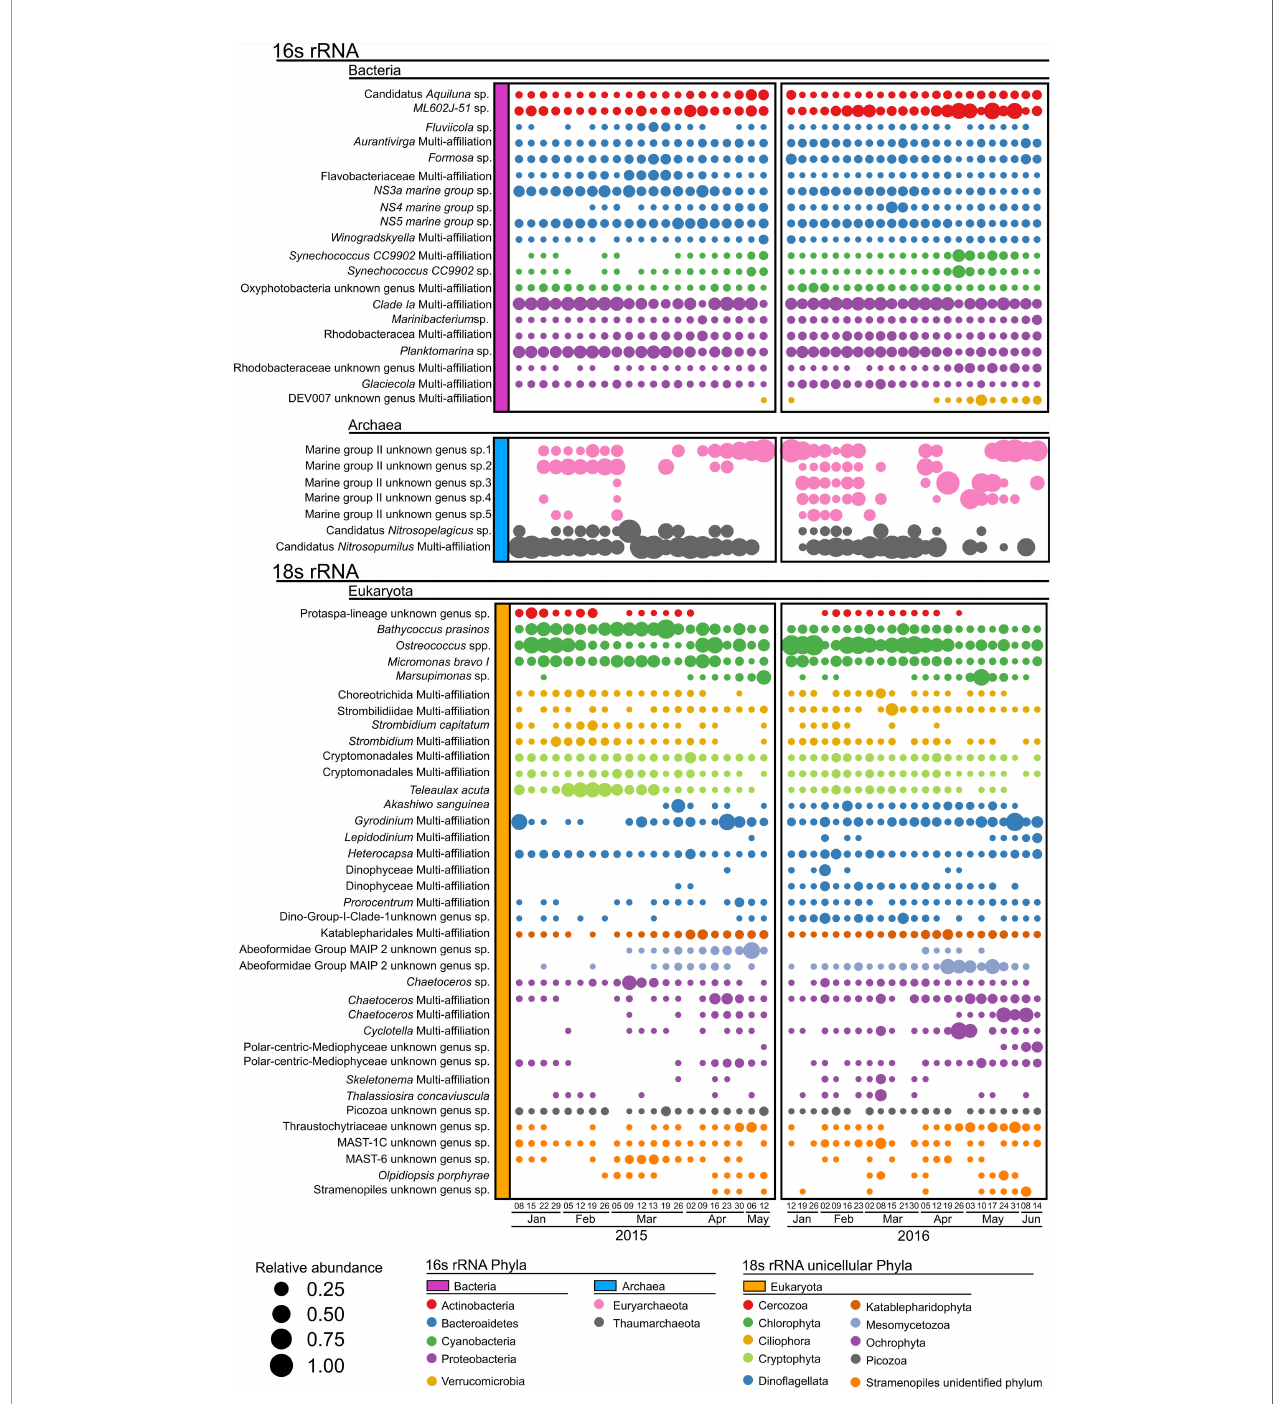
FIGURE 4 | Relative abundances ’ dot plot of the dominant OTUs for 2015 (left) and 2016 (right). Dots are proportional to the relative abundance of OTUs. Dominant OTUs are those exhibiting a maximum relative abundance > 5% in 2015 or